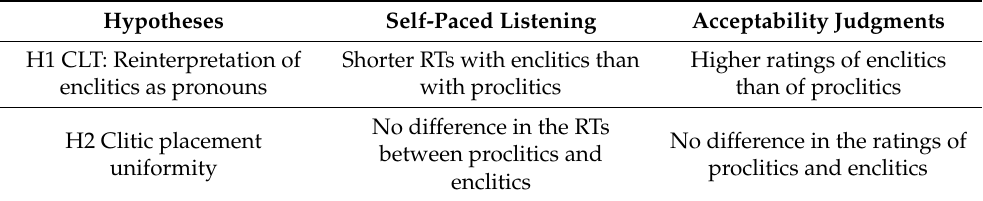
Table 2. Hypotheses and predictions for each task for the HSs